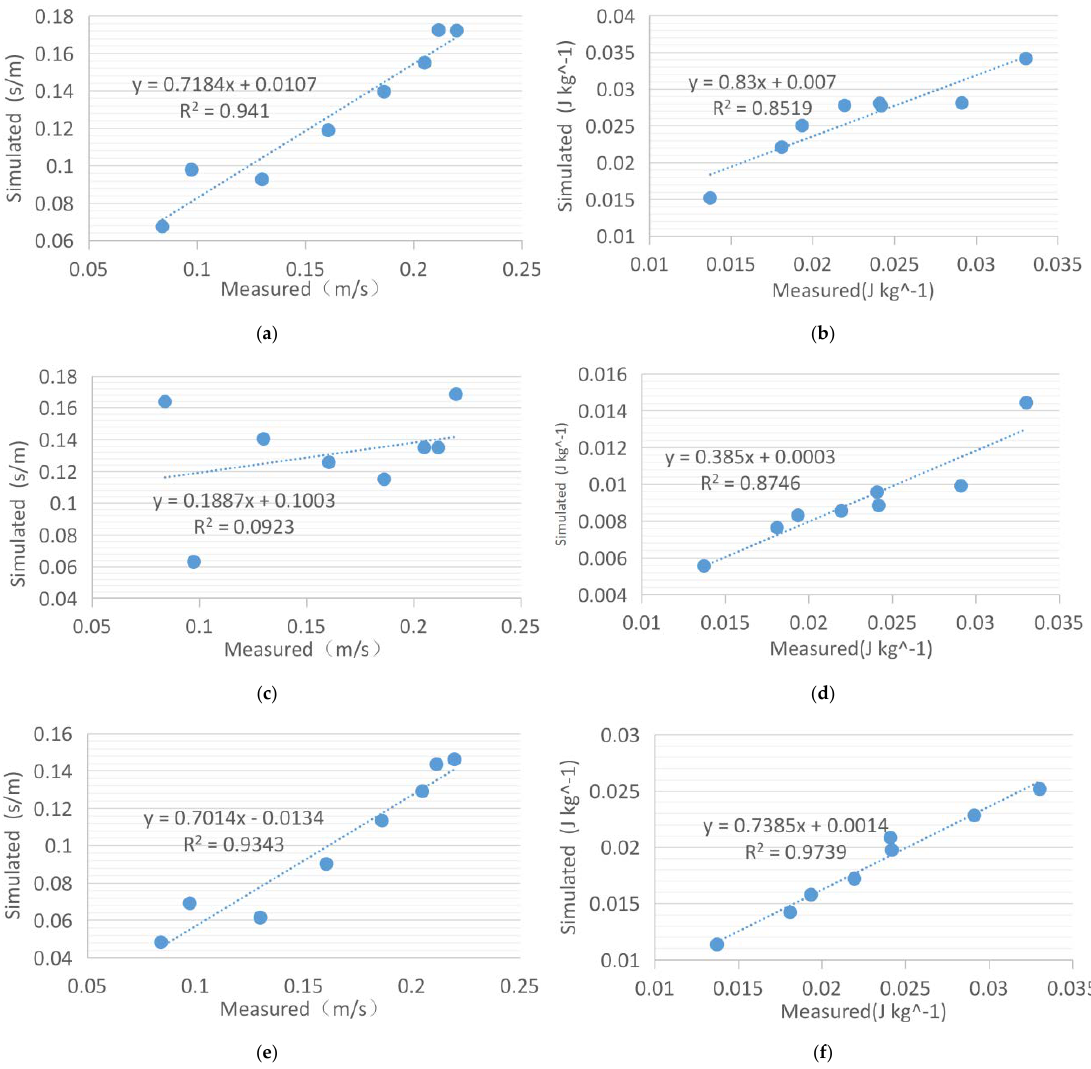
Figure 11. Analysis of measured and simulated data of SKE, RNG, and RKE at point 13. ( a ) Comparison of wind speed between SKE and measured data. ( b ) Comparison of turbulence intensity between SKE and measured data. ( c ) Comparison of wind speed between RNG and measured data. ( d ) Comparison of turbulence intensity between RNG and measured data. ( e ) Comparison of wind speed between RKE and measured data. ( f ) Comparison of turbulence intensity between RKE and measured